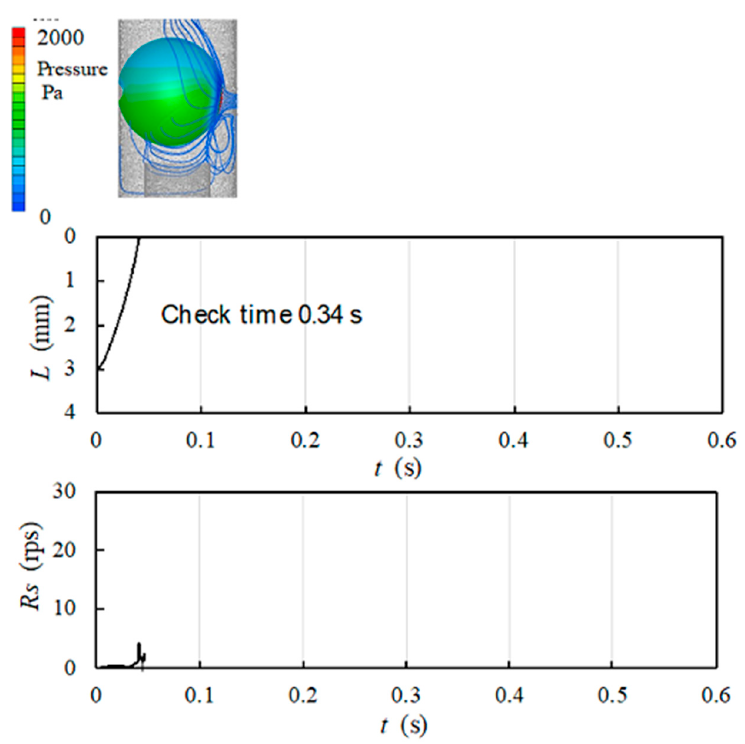
Figure 8. Time variation of lift and rotation speed in high-viscosity case of Model (b); Streamlines and ball surface pressure distribution 0.02 s.